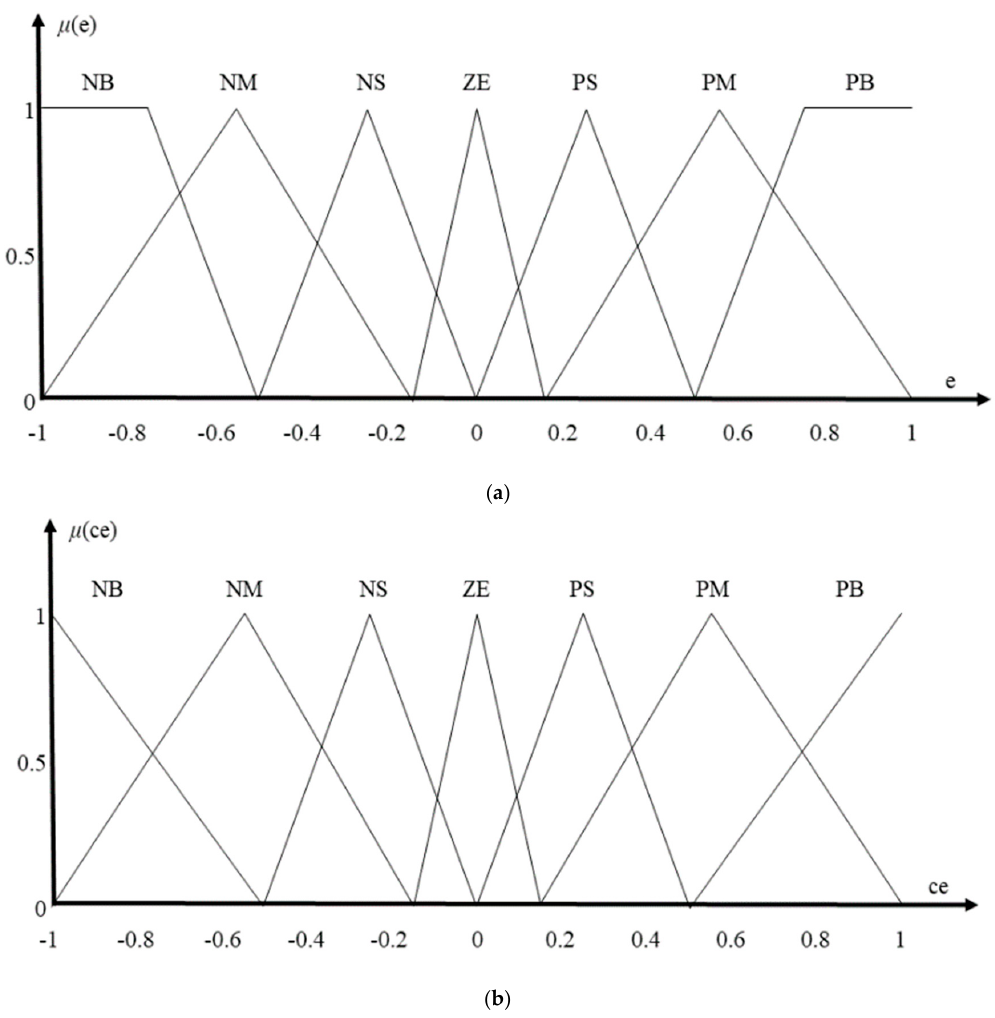
Figure 5. Membership function for the input value (error ( e ) and changing error ( ce )). ( a ) The error ( e ) membership function. ( b ) The changing error ( ce ) membership function.